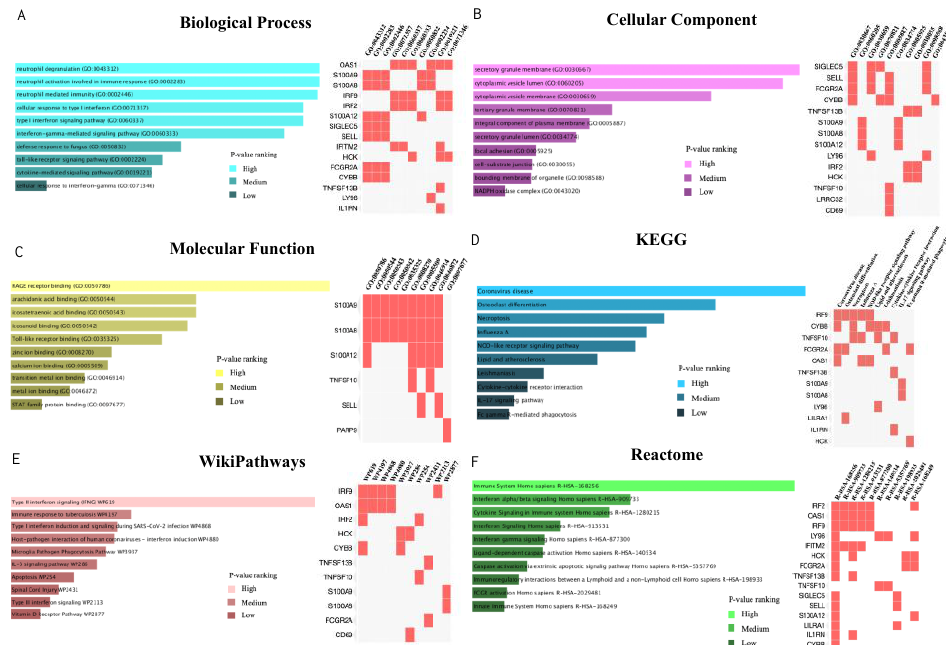
Figure 3. Common genes-based GO and pathway analysis sorted by adjusted p -values. Enriched genes are marked. ( A – C ) GO terms analysis results were shown, including biological process, cellular component and molecular function. ( D – F ) Pathway analysis results were identified by KEGG (Kyoto Encyclopedia of Genes and Genomes), WikiPathways and Reactome.